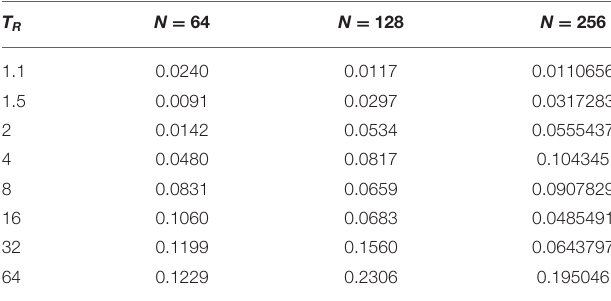
TABLE 2 | Relative variation δ of the average fluxes